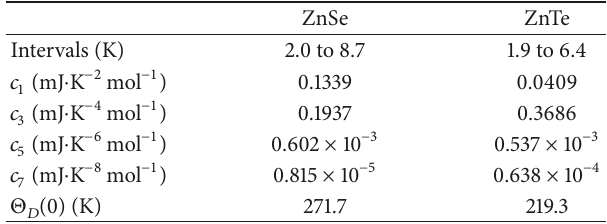
Table 3: Conventional Taylor series expansion coefficients deter- mined by least-mean square fittings of cryogenic 𝐶 𝑝 (𝑇)/𝑇 data [46] for ZnSe and ZnTe (see Figure 6) via (35). The respective Θ 𝐷 (0) values are resulting from fitted 𝑐 3 values via (34).